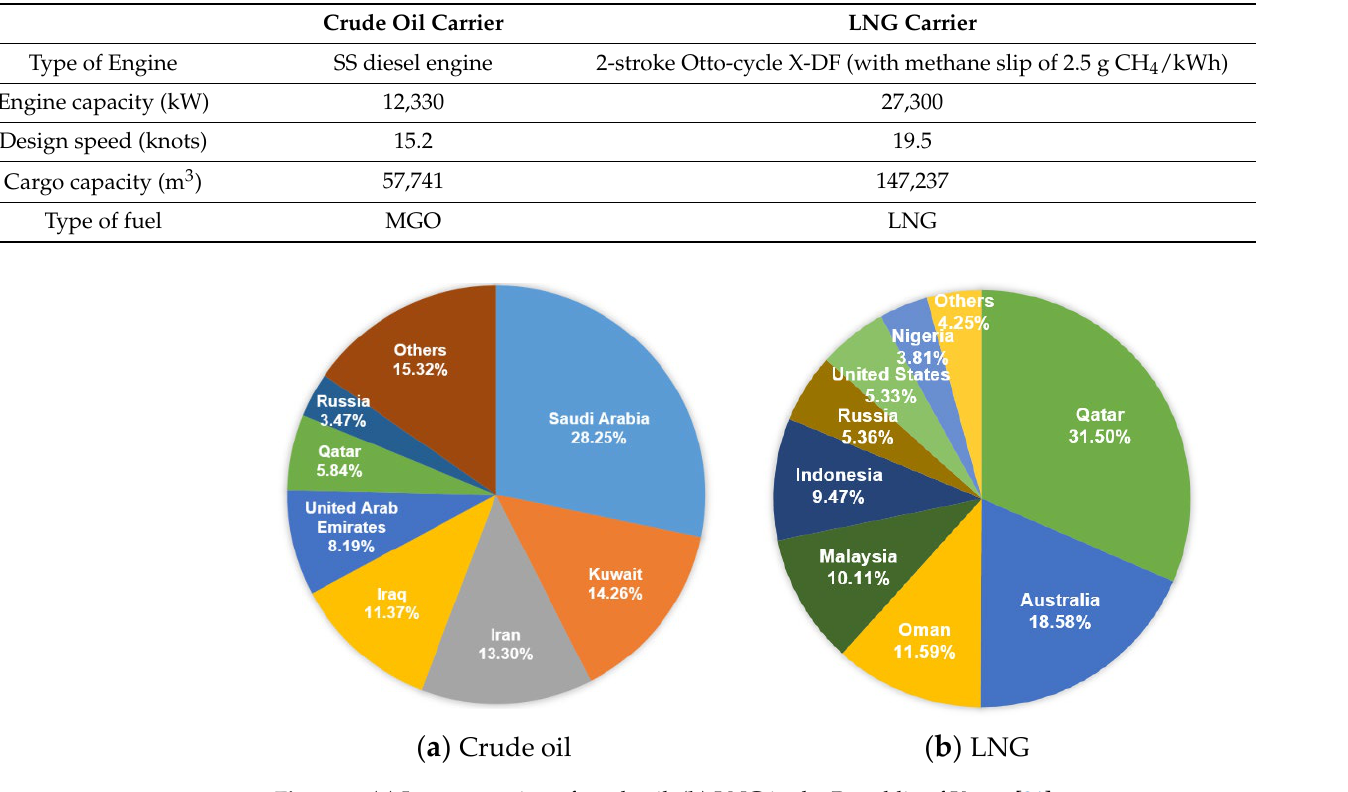
Figure 4. ( a ) Import portion of crude oil; ( b ) LNG in the Republic of Korea [31].